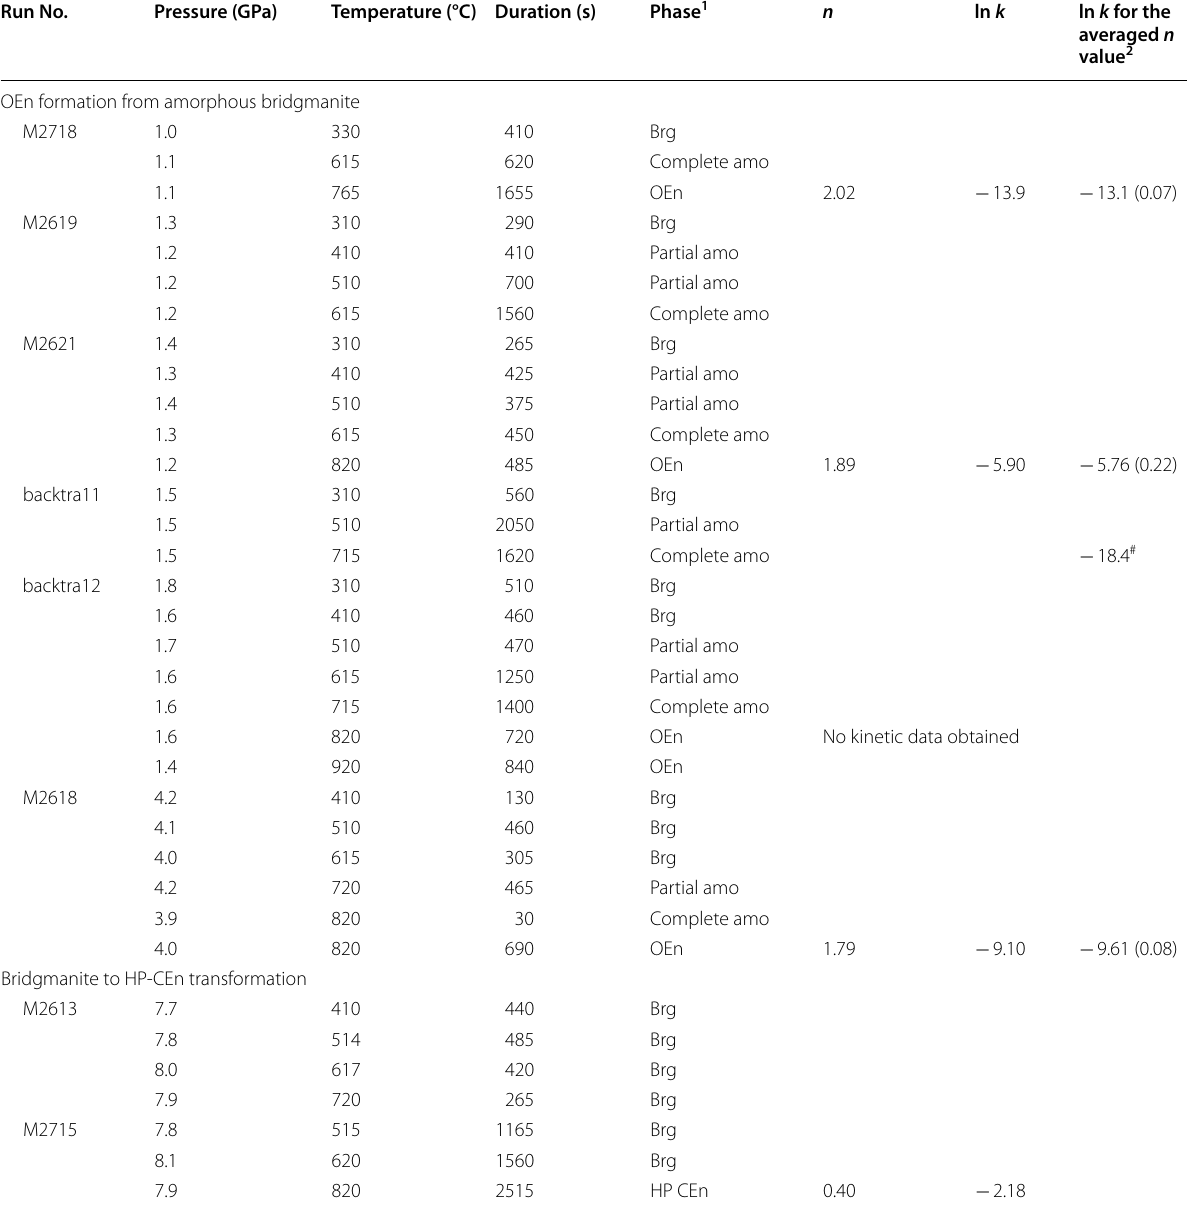
Table 2 P–T–t conditions and estimated values of kinetic parameters for the back-transformation in bridgmanite